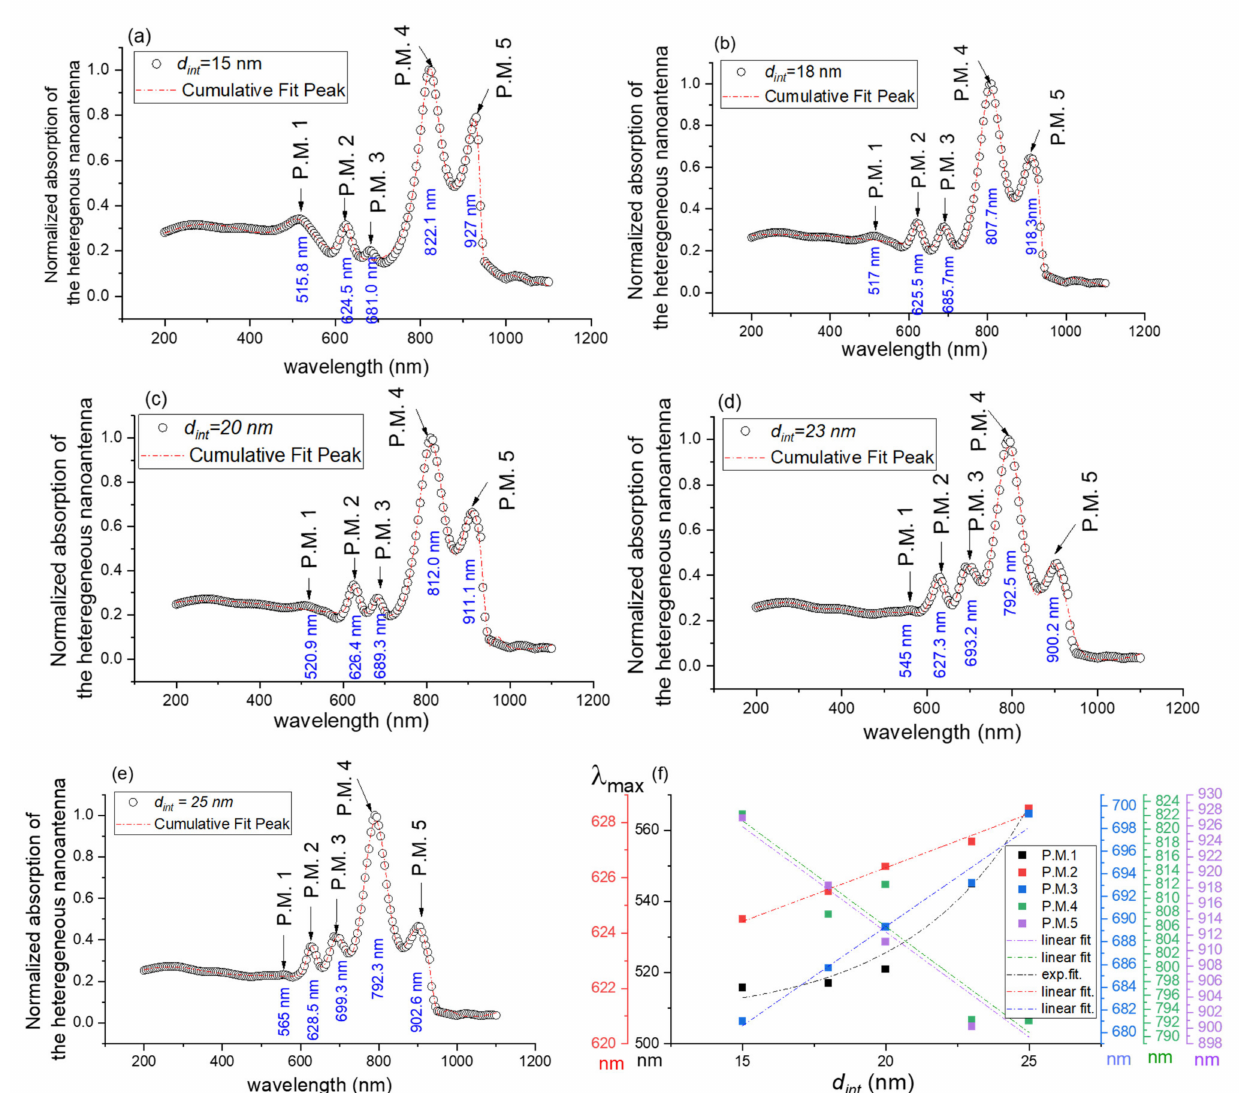
Figure 1. Normalized absorption cross section of the heterogeneous nanoantenna at variable wave- length form UV to near infrared for different interparticle distance in the yz plane d int =15 nm ( a ), d int = 18 nm ( b ), d int = 20 nm ( c ), d int = 23 nm ( d ) and d int = 25 nm ( e ). ( f ) Plasmon shift variation at variable interparticles distances. Silicon antenna radius r Si = 10 nm, length L = 70 nm, Ag/Au core-shell radius r Ag@Au = 5 nm, d int (in the xy plane) = 1 nm. The two other plasmon bands denoted by plasmon mode 4 (P.M.4) and plasmon mode 5 (P.M.5) are located in the near-infrared regions at 822.1 nm and 927.0 nm, respec- tively, for d int = 15 nm. By varying the interparticle distance in the zy plane from 15 nm